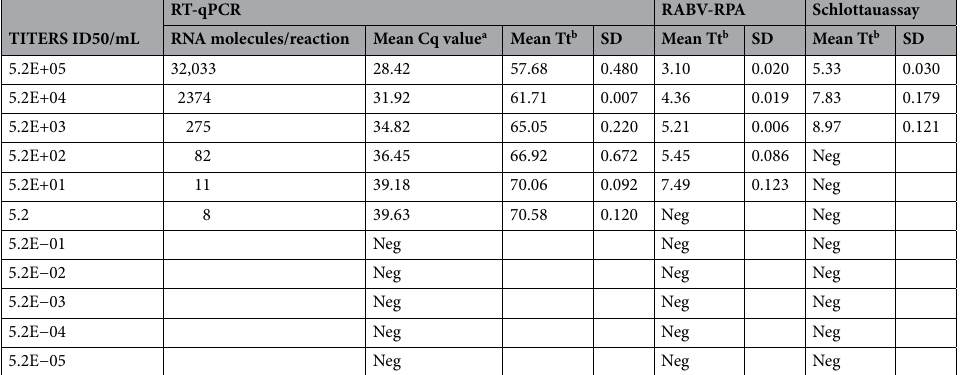
Table 3. Detection limit of the new established RT-RPA assay on cerebro-spinal fluid sample. Tenfold serial dilutions of RABV isolate SA217695SEN with an initial virus titer of 5.2 10 6 ID 50 /mL were tested with an rabies virus RT-RPA assay previously described by Schlottau et al. 21 and the new RT-RPA assay. The corresponding numbers of RNA molecules per reaction were calculated using the mean Cq values with the standard equation previously described for the RT-qPCR used here as reference technique 19 . Neg: negative or no fluorescence signal, Cq : quantitative cycle number, Tt: time threshold (minutes). a Mean Cq value from duplicates. b Mean Tt value from